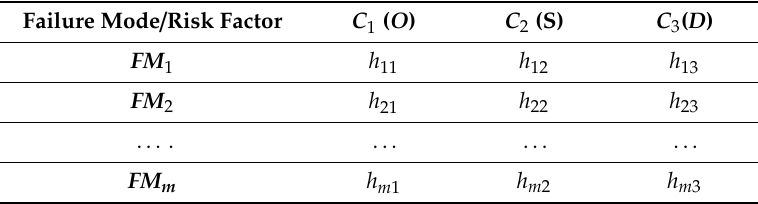
Table 1. Hesitant fuzzy decision